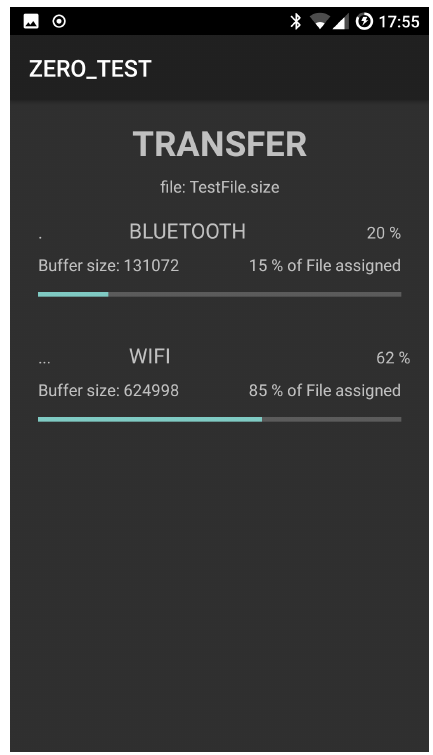
Figure 10. Transferring of data combining Bluetooth and